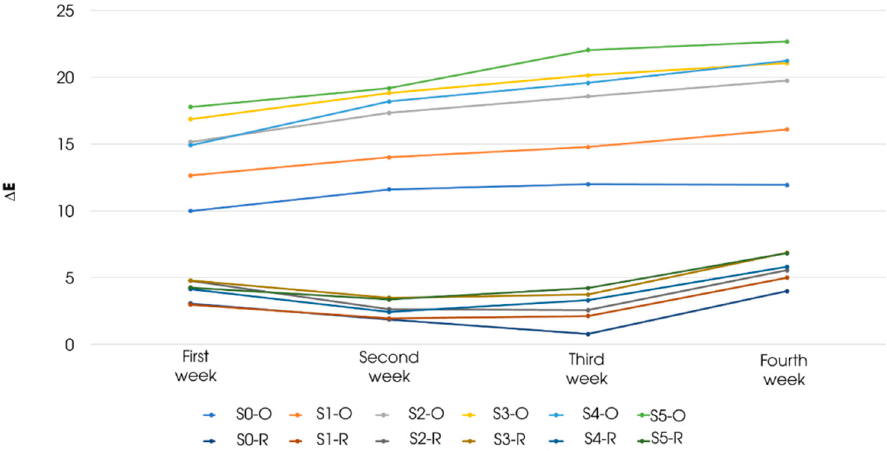
Figure 13. The change of color of the different dried extracts at room temperature and at 45 °C.